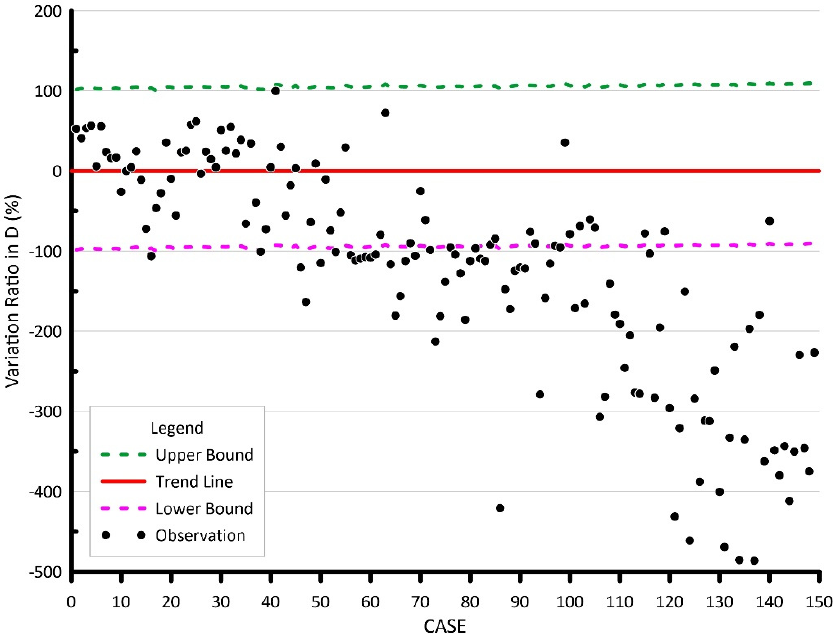
Figure 9. Comparison between predicted and estimated values of collapse thickness in 149 potential LSL areas.